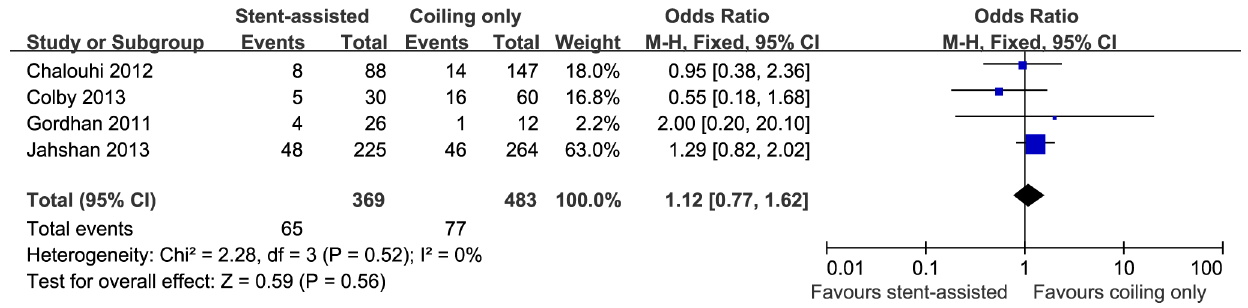
Figure 4. Forest plot of all-complication rate comparing stent-assisted coiling versus coiling only. Fixed-effect model was applied.